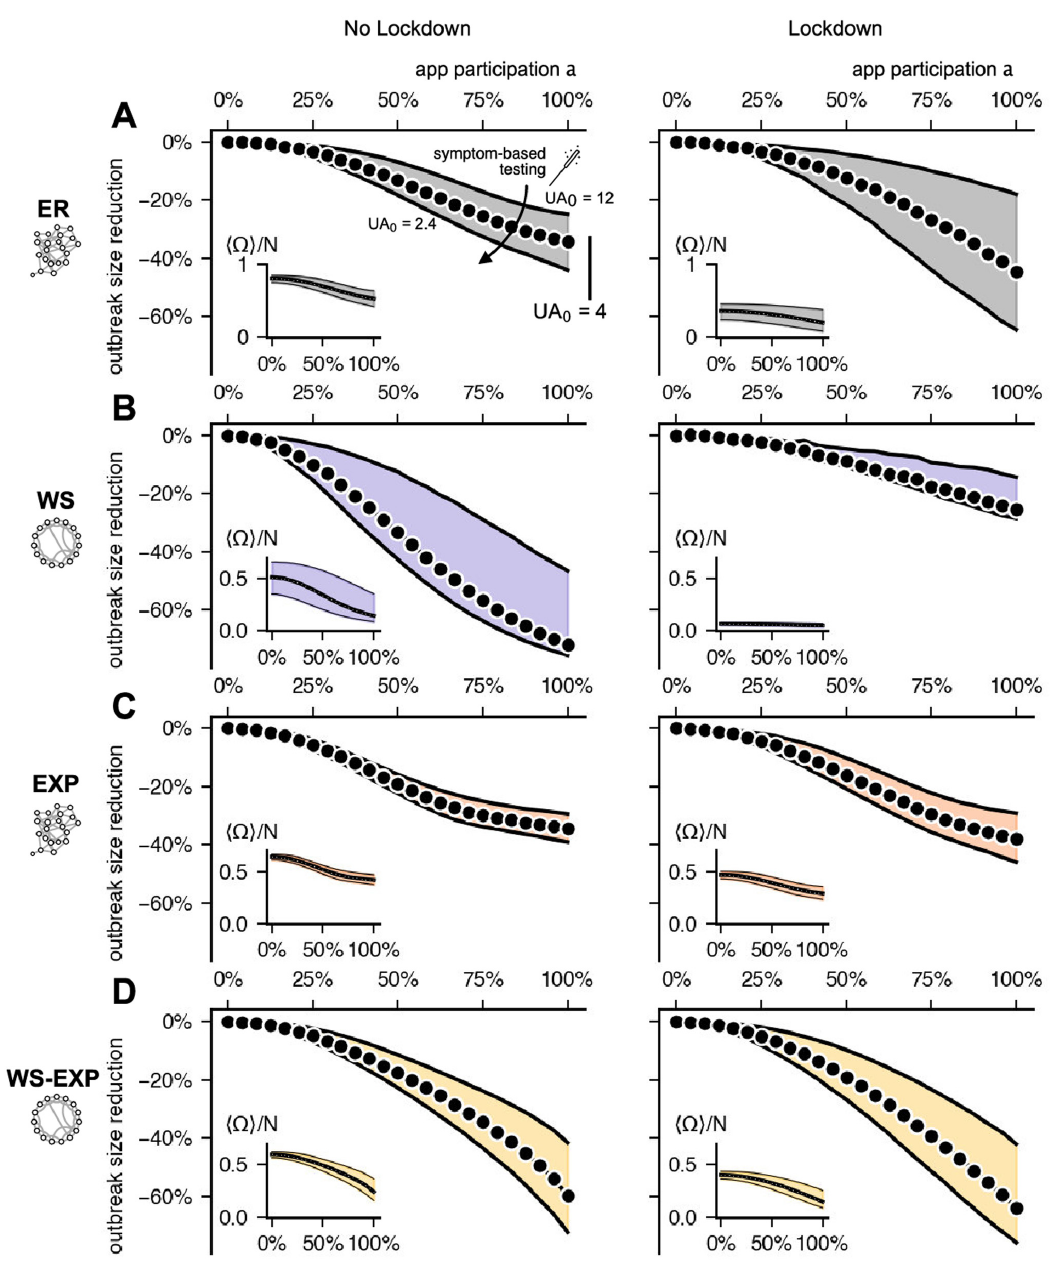
Fig 5. Capturing “lockdown” measures in our model, we compare the relative mean outbreak size reduction for (A) ER, (B) WS, (C) EXP and (D) WS-EXP networks in a situation where (left) the disease spreads freely to a situation where (right) the disease’s spread is mitigated by reducing the number of contacts by 40% while maintaining the transmission rate per link. Despite what our result of Fig 3 implies, the locally clustered structure does not enhance DCTs success when the disease is sub- critical. This suggests that super-criticality is necessary for DCT to work more